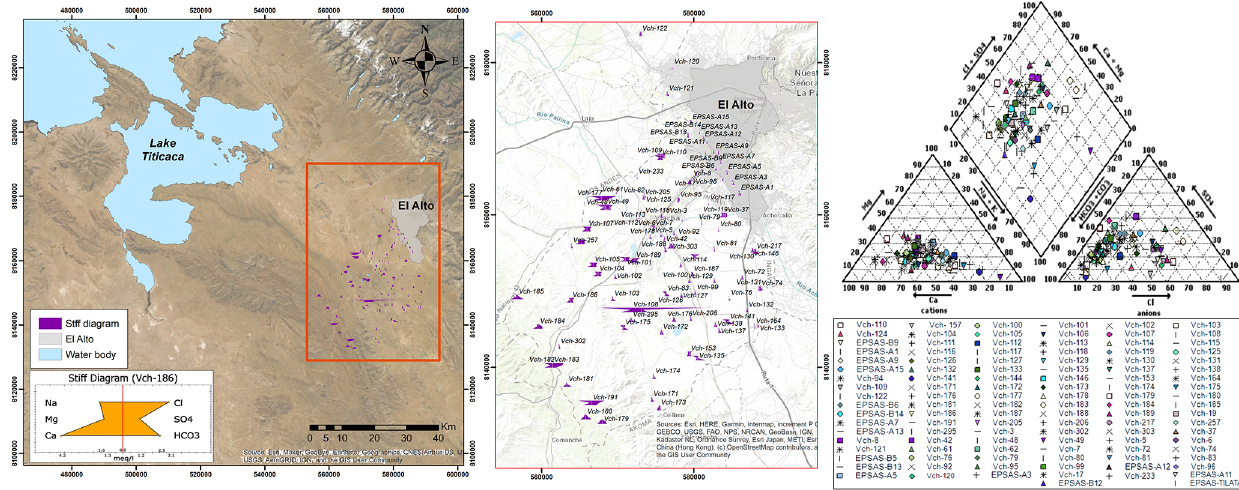
Figure 3. Hydrochemical data compiled (1987–2018) including latest campaign (2019). The mean compositions of the data gathered at each point are shown in the left and middle figures (Stiff diagram). Wide variations between bicarbonate-calcium and bicarbonate-sodium waters are shown in the right picture (Piper diagram) (right figure). There are significant differences in Ingavi’s center and boundaries (areas with an increase industrial development). Source for basemap: ArcGIS (ESRI).